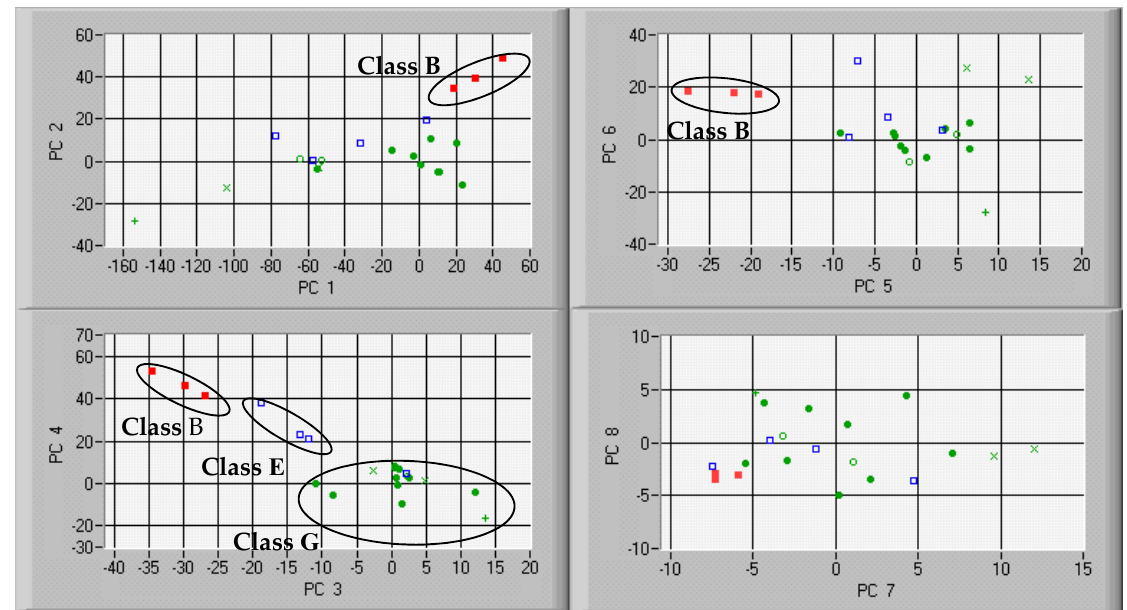
Figure 9. Representation of devices by PC1–PC8 for acquisition time equal to 5 min.